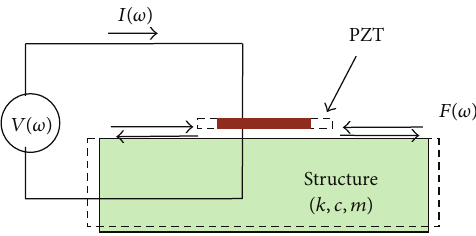
Figure 2: Model of coupling interaction between PZT transducer and